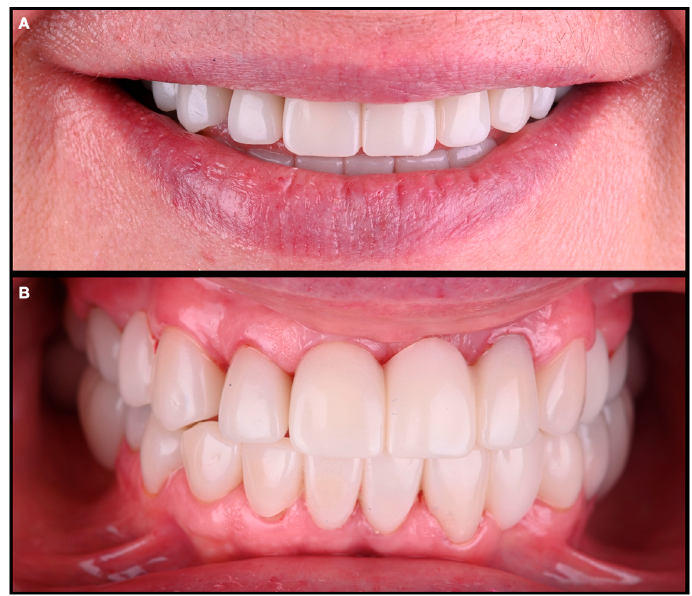
Figure 9. Full mouth provisional restorations. ( A ) Smile. ( B ) Maximum intercuspation position. After four months of healing time, tooth preparations were refined, final digital impressions (iTero Element 5D, Align Technology, Inc, San Jose, CA, USA) were taken, and the final restorations were designed (DentalCAD 3.1, Exocad GmbH, Darmstadt, Germany) (Figure 10).